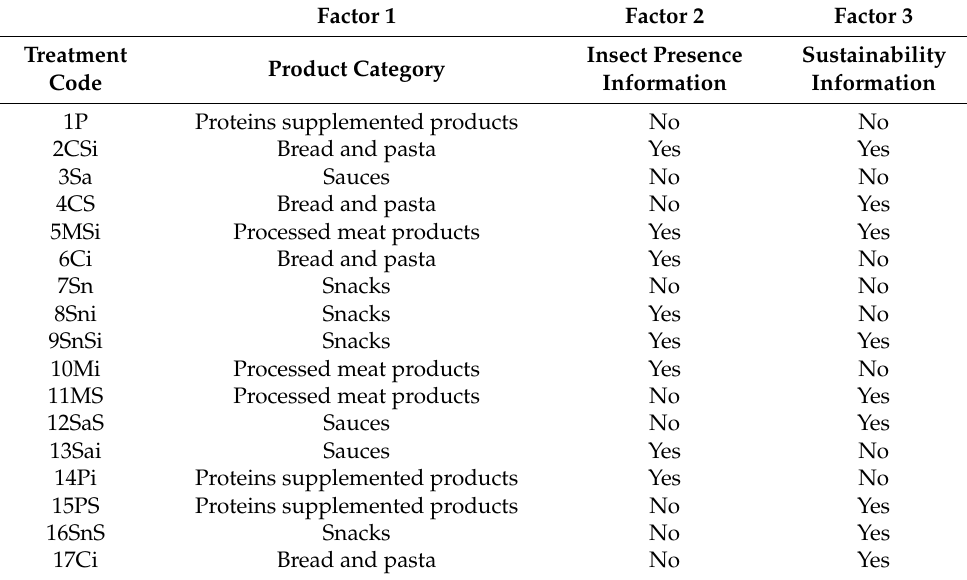
Table 1. The 17 treatments evaluated in this experiment. The Product Category was indicated by the first one or two letters (C for bread and pasta, M for processed meat products, P for protein supplemented products, Sa for sauces, and Sn for snacks). Sustainability Information was indicated by the letter S only if the information was provided in the treatment. The letter i indicated the Insect Presence Information only if the information was to be given. For the treatment designated 1P, the subjects saw a picture of protein supplemented products (P), with no Sustainability Information or Insect Presence Information, but for the treatment designated 9SnSi, the subjects saw a picture of snacks with both Sustainability Information and Insect Presence Information. Factor 1 Factor 2 Factor